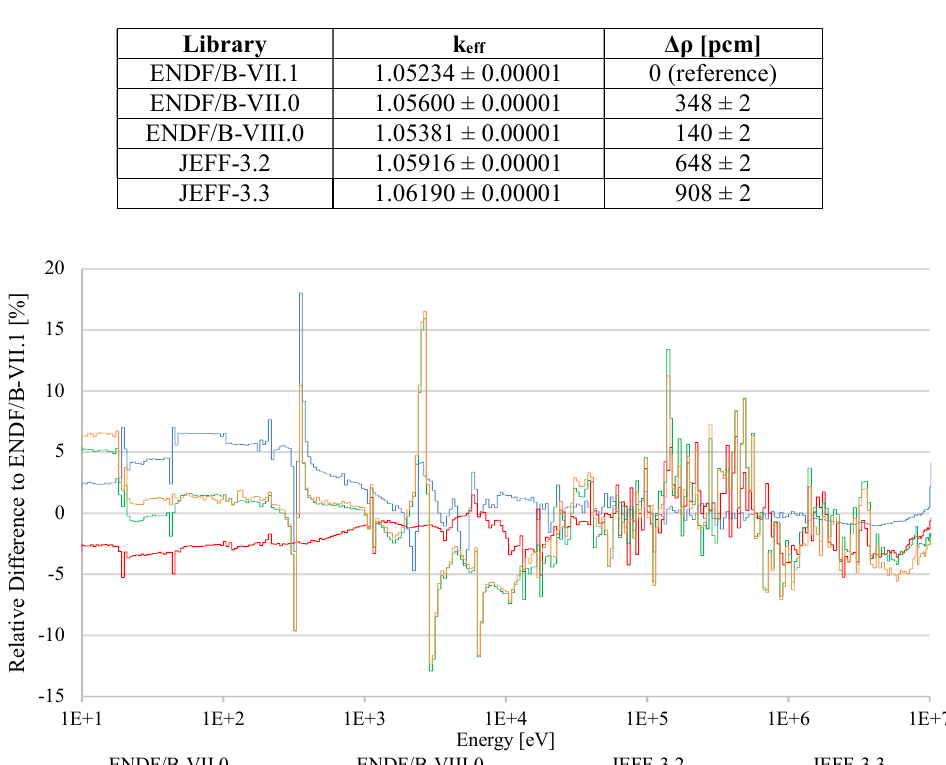
Table I. Eigenvalue differences: Comparison of nuclear data libraries .